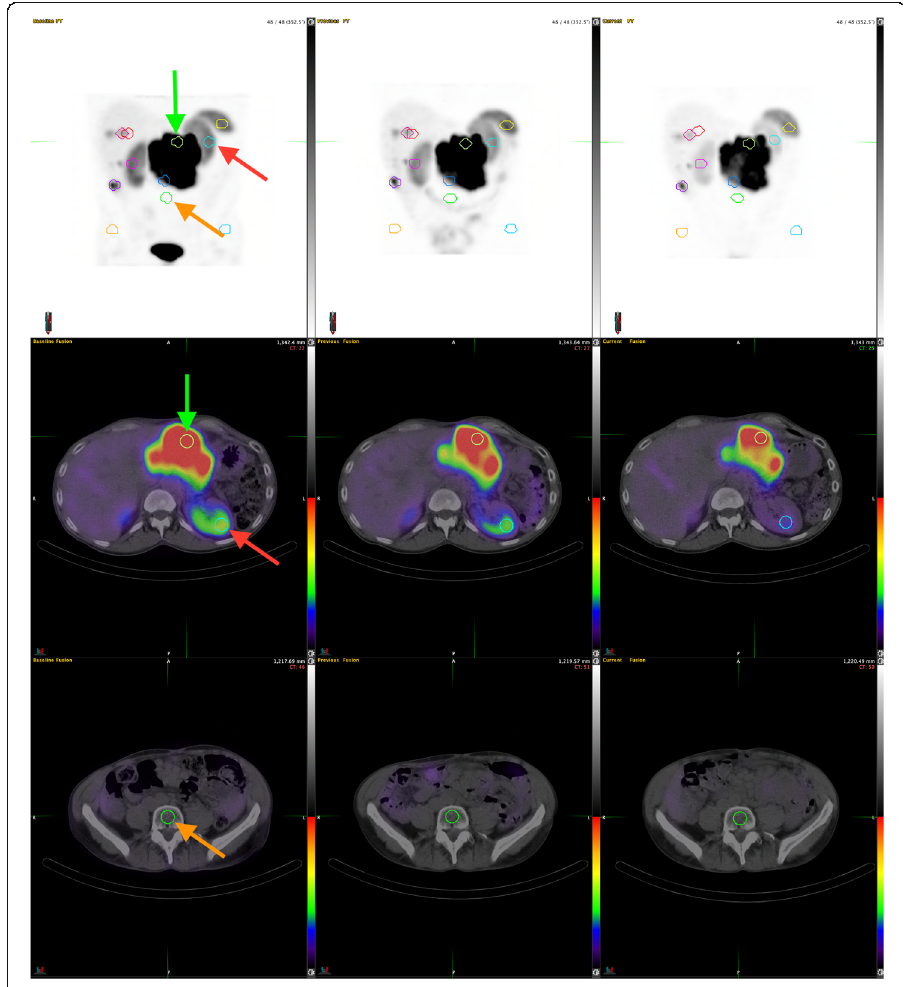
22.0 GBq 177 Lu-octreotate administration in a 55-year-old male with metastatic NET of unknown origin. Small volumes of interest (2-cm diameter) were placed over tissues of interest. Left kidney (red arrows), L5 bone marrow cavity (orange arrows), and dominant tumor (green arrows) VOIs are pointed on anterior maximum intensity projections (top row) and selected transaxial fusion slices (mid and bottom rows). QSPECT images are normalized using an upper SUV threshold of 7. During this consolidation cycle, the personalized injected activity allowed the delivery of 6.1 Gy (6.0 Gy prescribed) to the